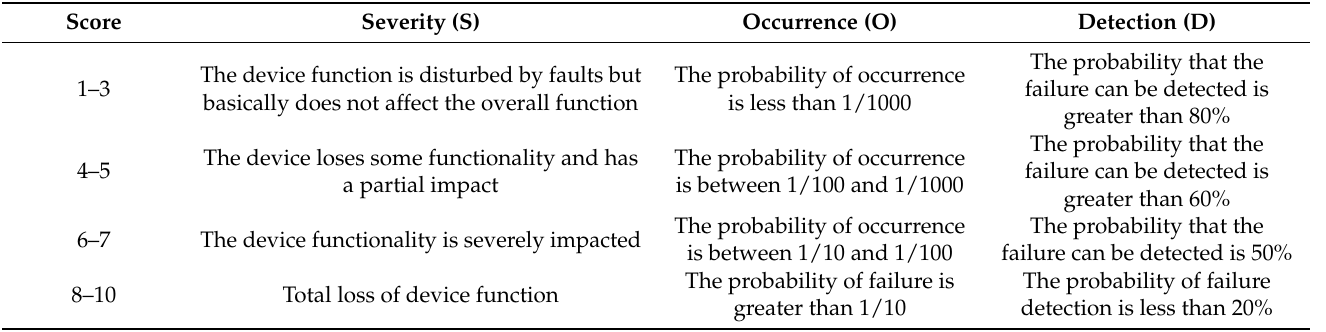
Table 1. Evaluation table of failure model risk evaluation